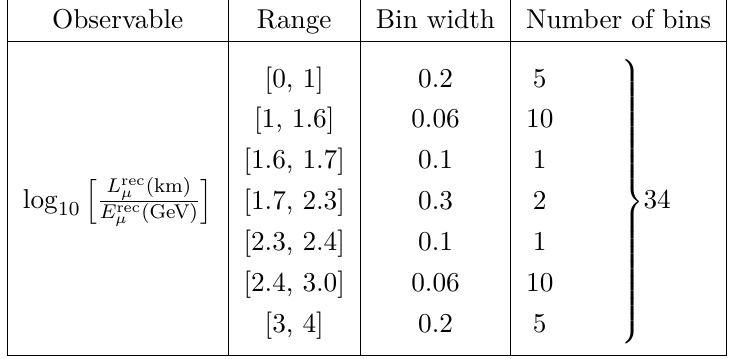
[ L rec ] for µ − and µ + /E rec 10 µ µ